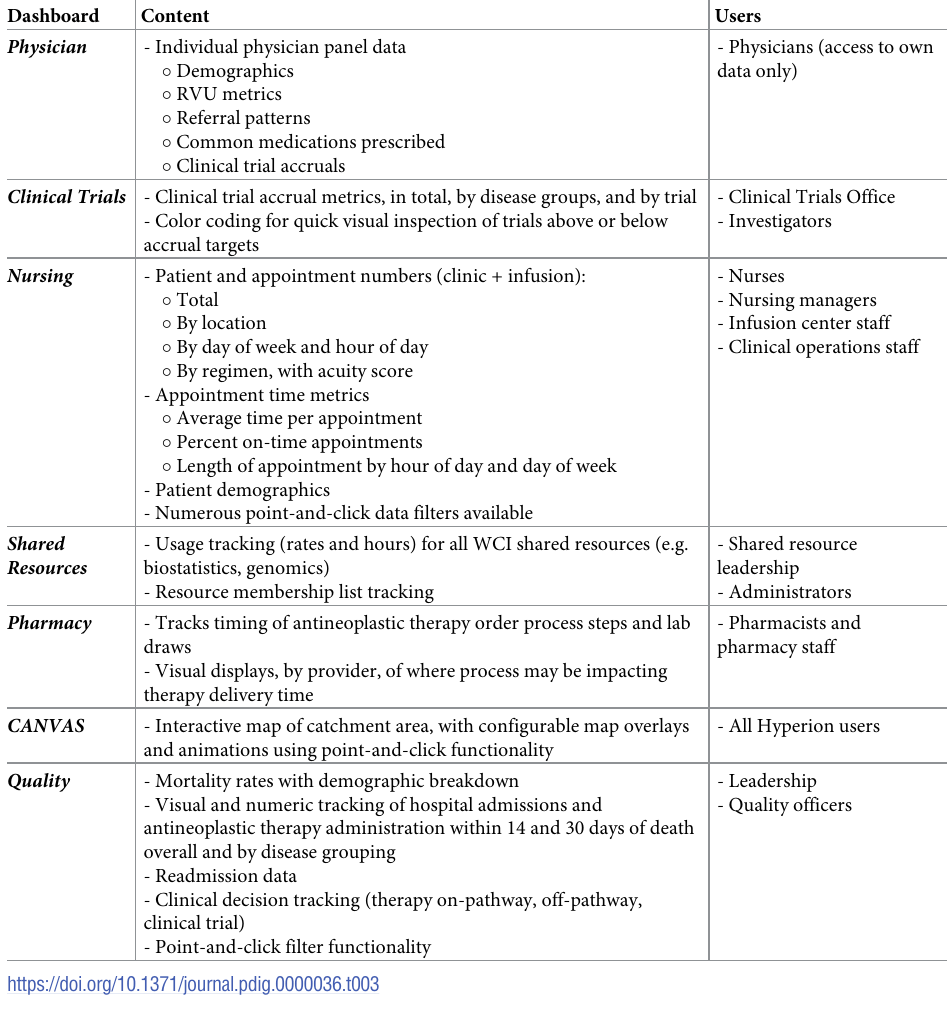
Table 3. Example user dashboards. See supplementary material for sample